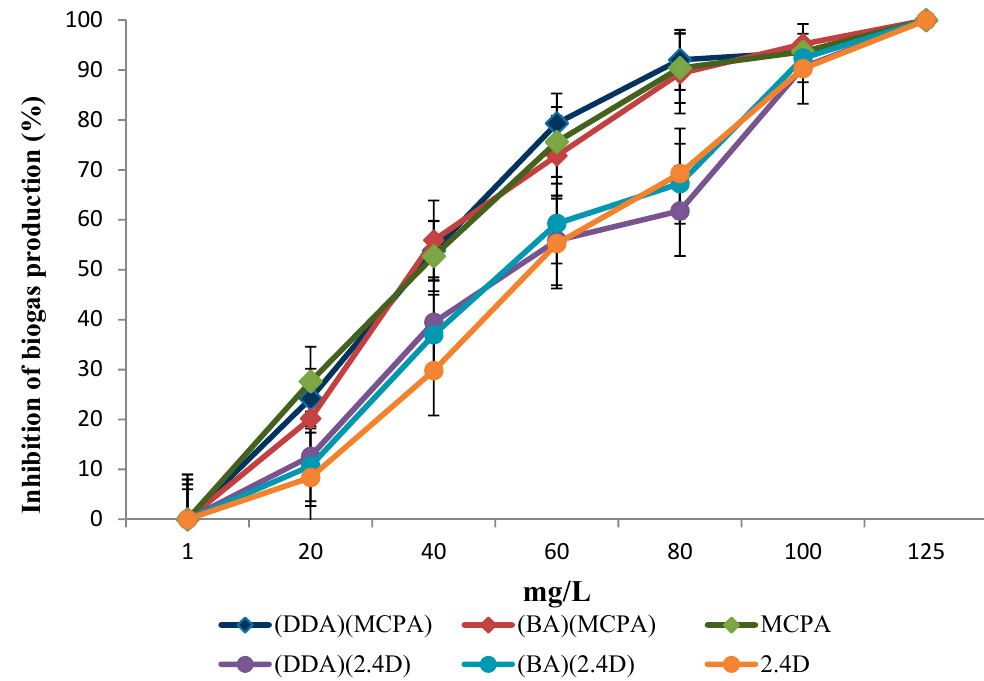
0102030405060708090100 Figure 1. The effect of selected ionic liquids (benzalkonium (2,4-dichlorophenoxy)acetate (BA)(2,4-D), benzalkonium (4-chloro-2-methylphenoxy)acetate (BA)(MCPA), didecyldimethylammonium (2,4-dichlorophenoxy)acetate(DDA)(2,4-D),didecyldimethylammonium(4-chloro-2-methylphenoxy)acetate (DDA)(MCPA) as well as 4-chloro-2-methylphenoxy)acetic acid (MCPA) and 2,4-dichlorophenoxy)acetic acid (2,4-D) on the inhibition of biogas production. All fermentation experiments were carried out in